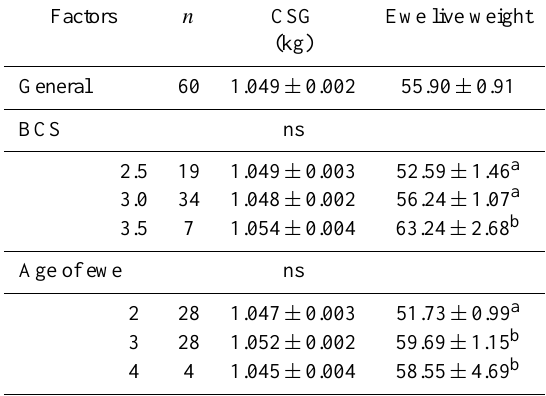
Table 4. Correlation coefficients among body condition score (BCS) at lambing, ewe live weight (LW), age of ewe (AGE), colostral specific gravity (CSG), and total weight of lamb born